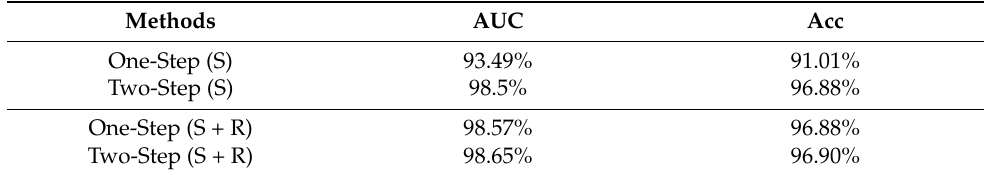
Table 6. A comparison of the vessel segmentation results on the DRIVE dataset between the one-step and the two-step methods.